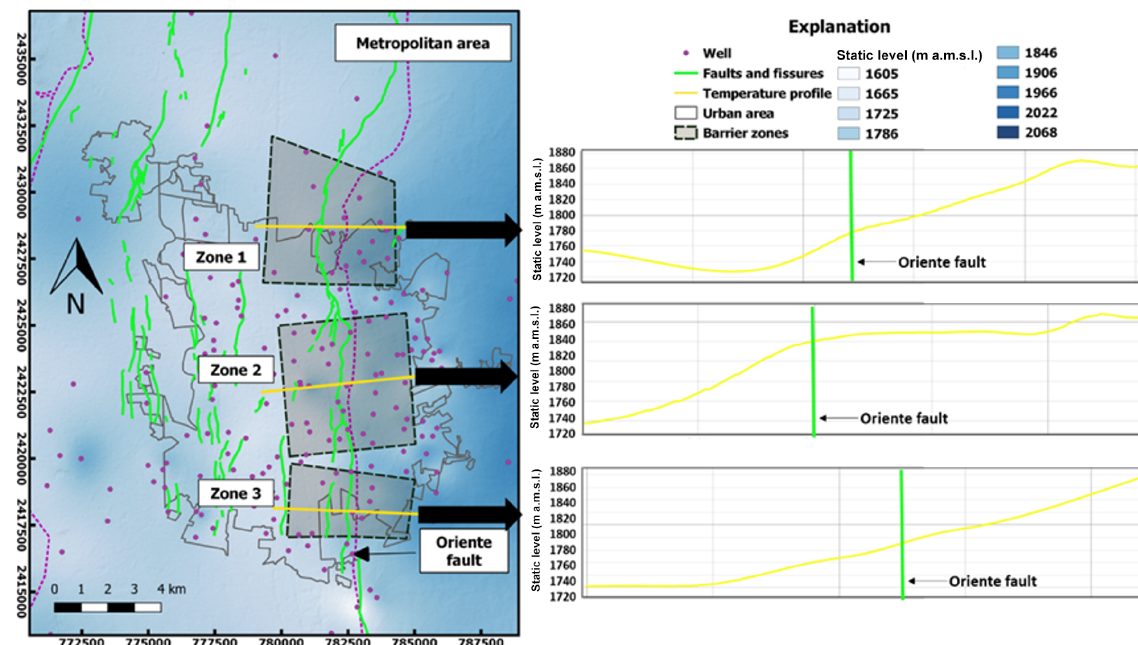
Figure 4. Comparison of hydraulic heads and the Oriente